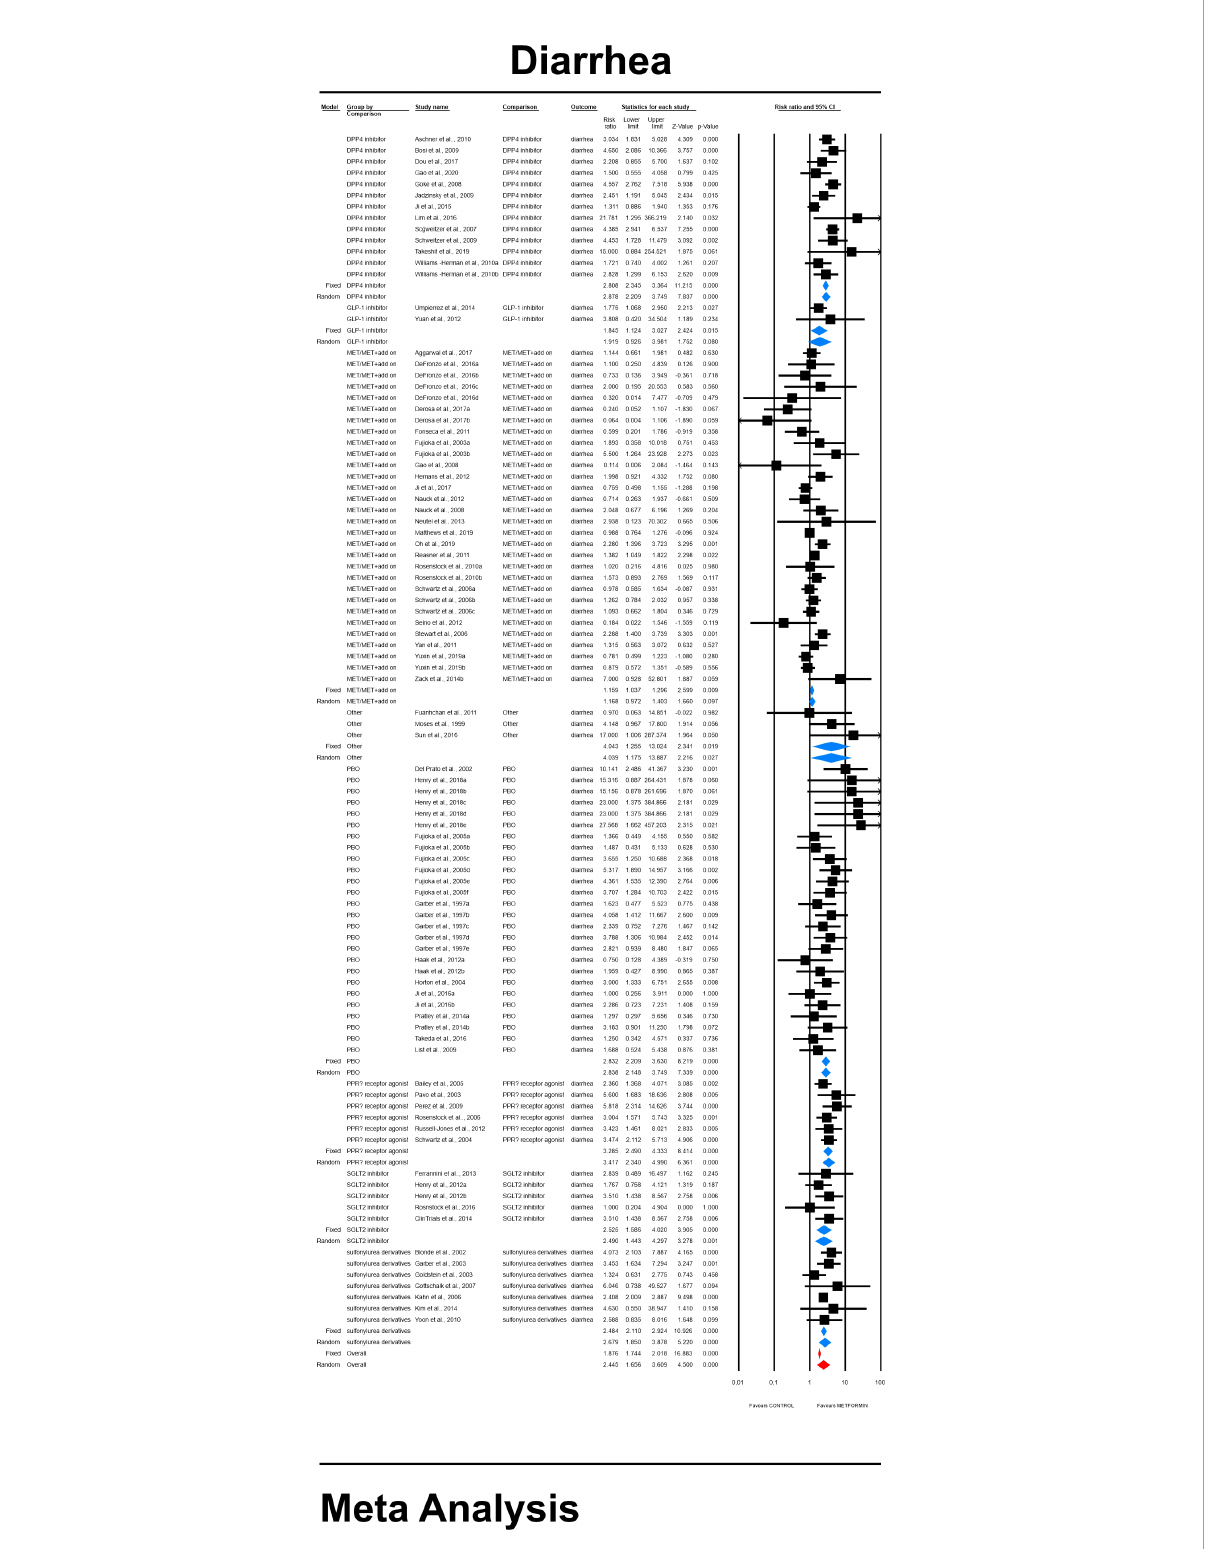
FIGURE 7 The effect size (RR) for diarrhea in patients taking metformin (intervention) vs. comparator